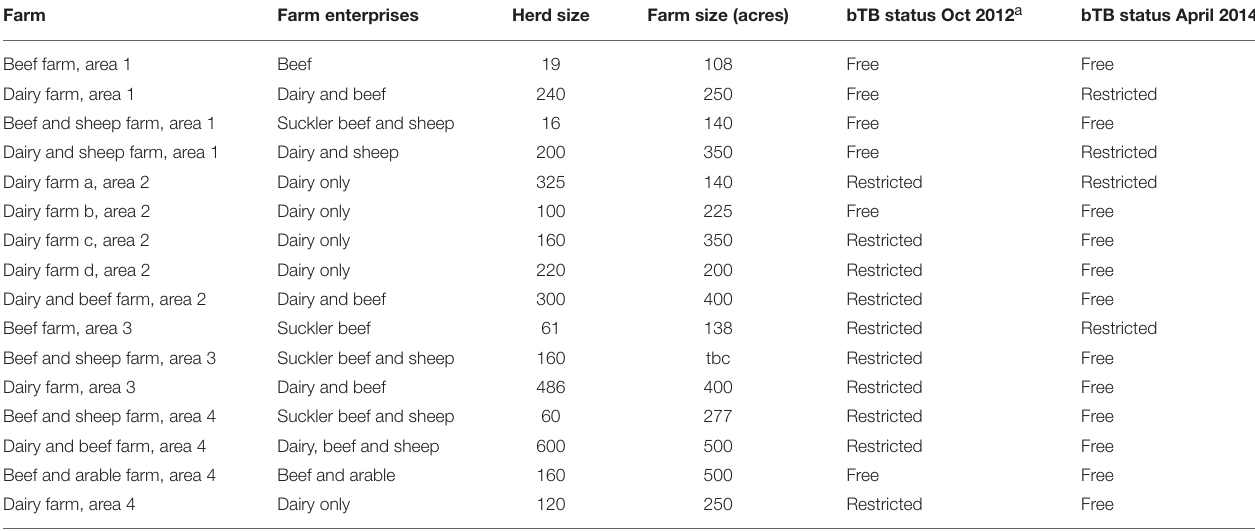
TABLE 1 | Breakdown of farm characteristics for farmer participants.